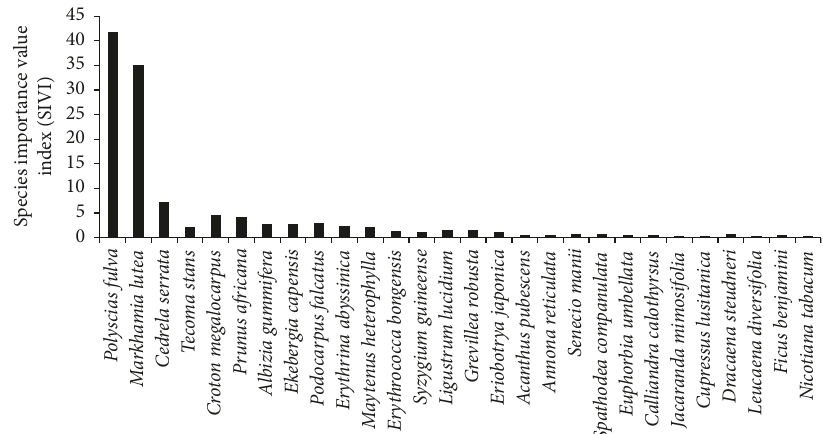
Figure 10: Importance value indices of woody species identified in the self-regenerated secondary forest in Ruhande Arboretum, Huye,